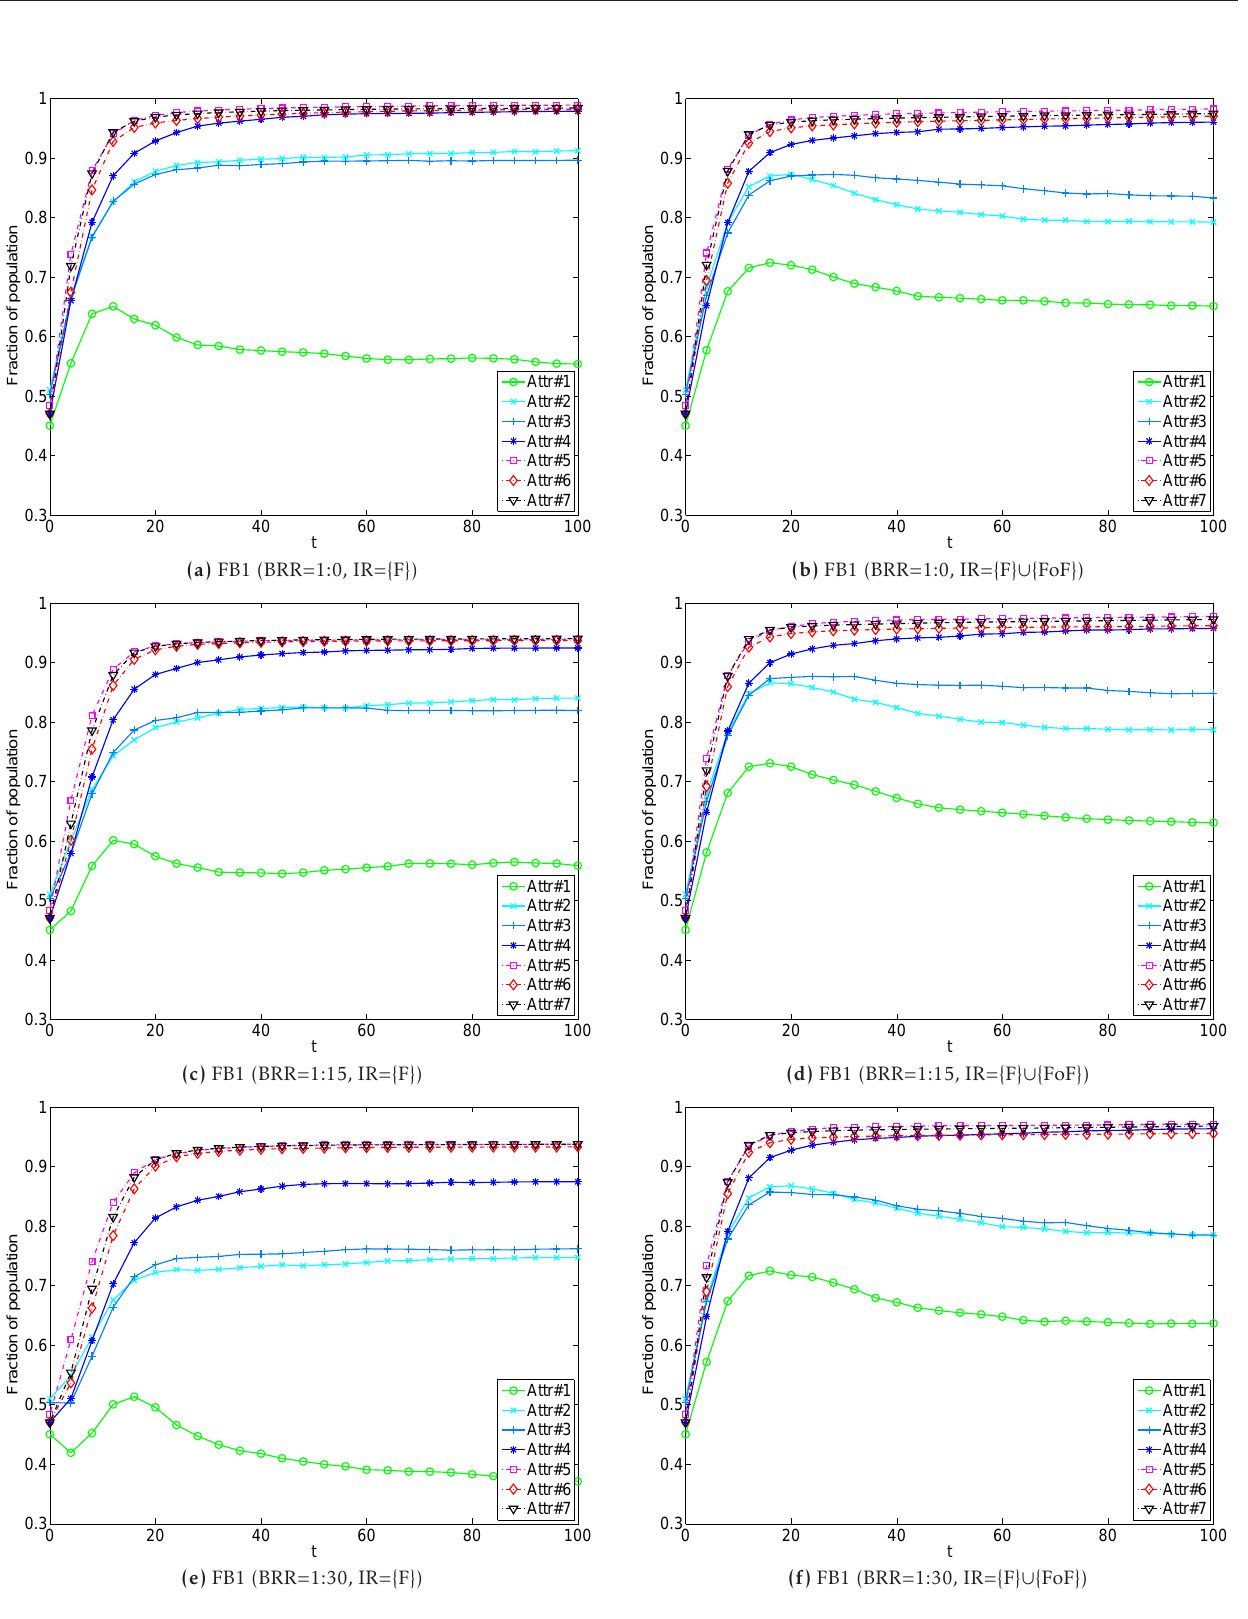
Figure 9. Attribute dynamics for the weighted evolutionary game in FB1. The figures in left column correspond to applying Friends as the influential range of the utility